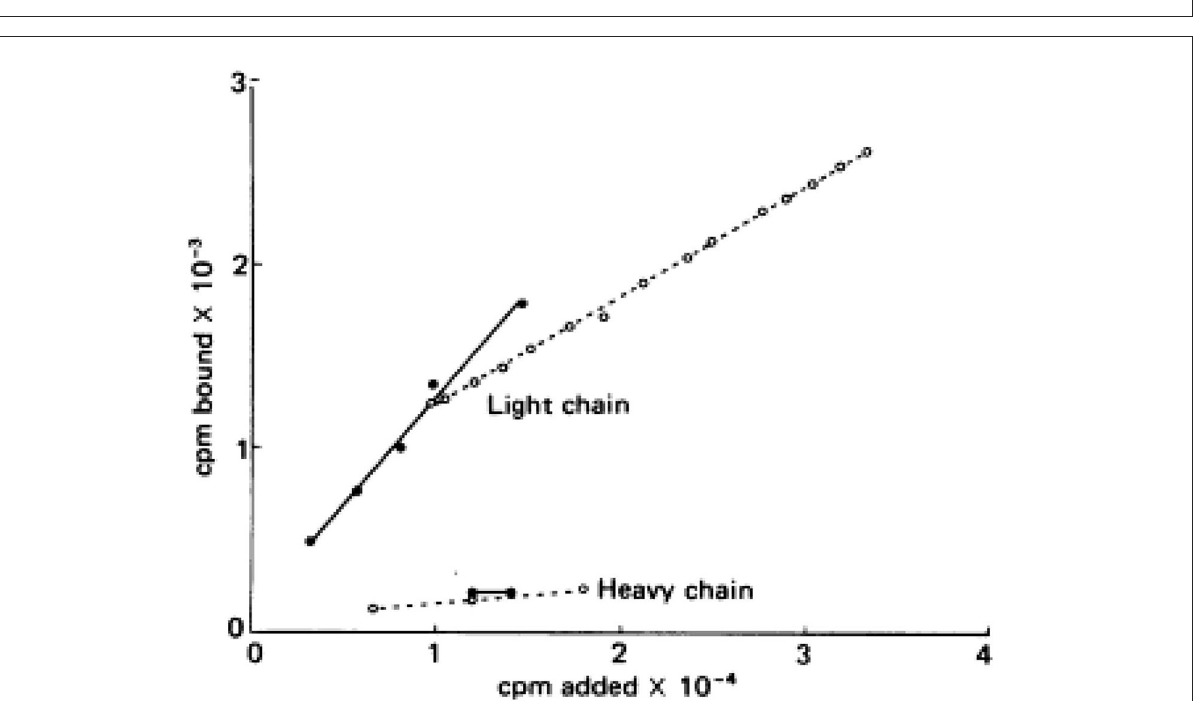
FIGURE4 Addition of 125 I—factor XI (solid lines) or 125 I—prekallikrein (dotted line) to surface-bound light chain or heavy chain purified from HK. The counts bound (vertical) per moles added (horizontal) are plotted.